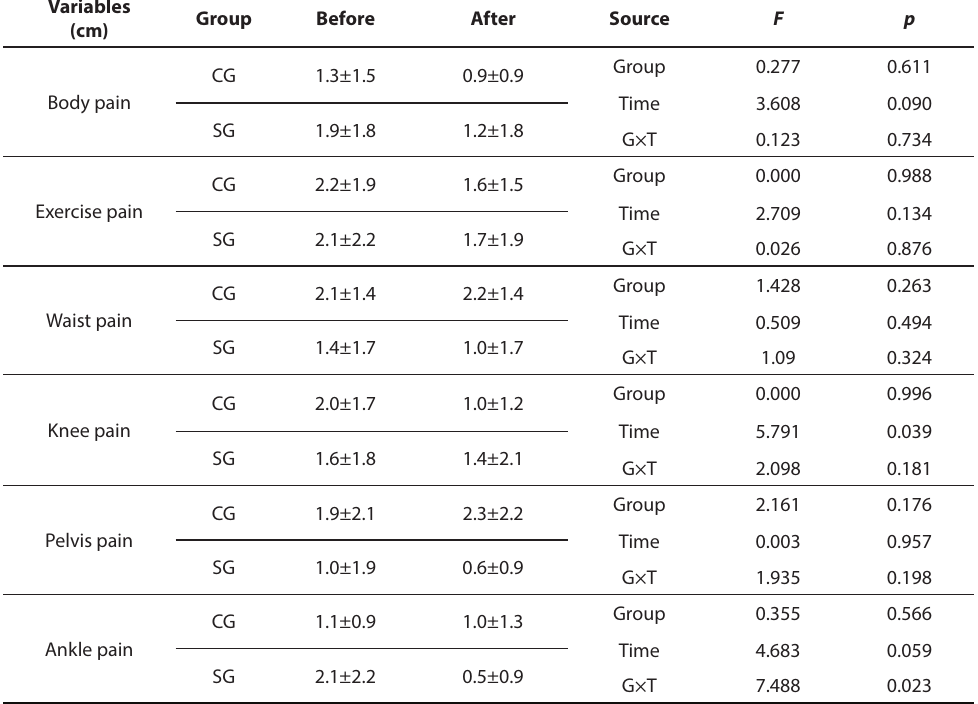
TABLE 5. Effects of a 4-week Core Stability Exercise on VAS Variables (cm)